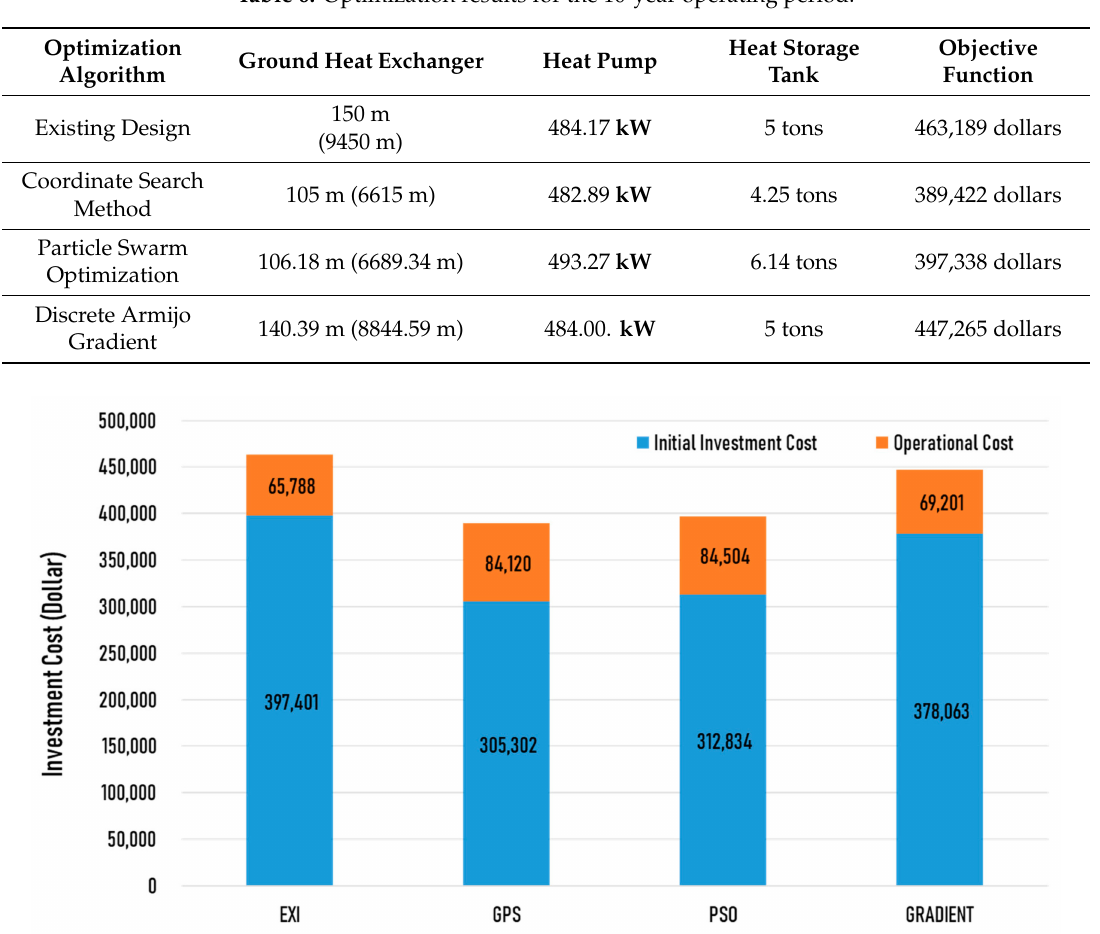
Table 6. Optimization results for the 10-year operating period.